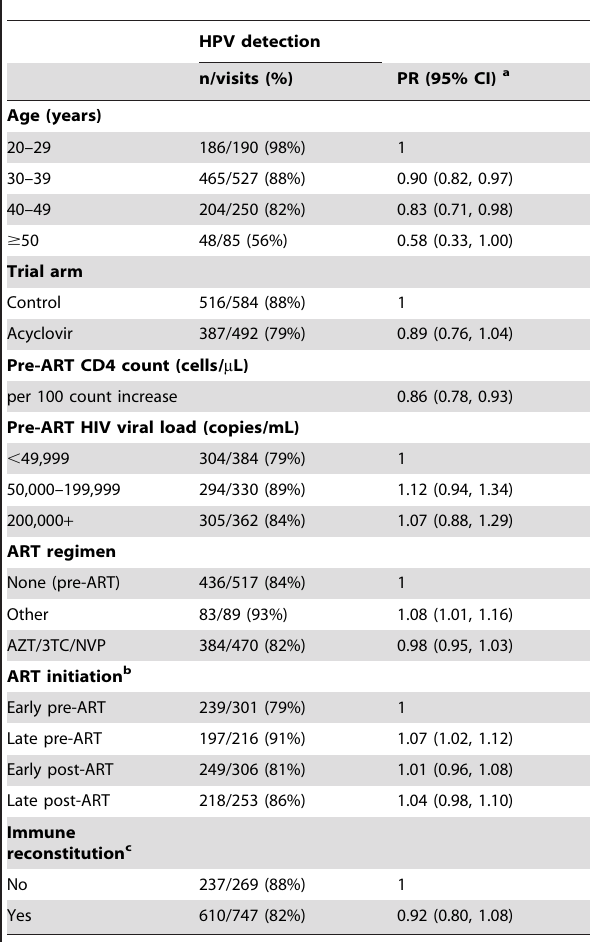
Table 4. Prevalence ratios for detection of any type HPV per visit per women in the pre-ART, post-ART and pre-vs. post- ART